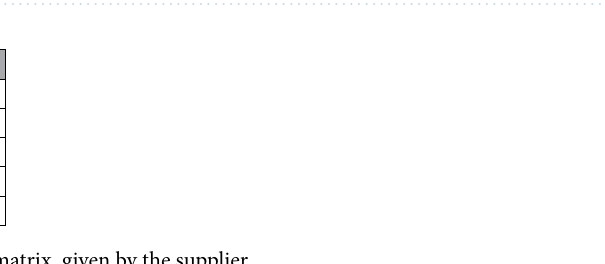
Table 2. Properties of reinforcement and matrix, given by the supplier.